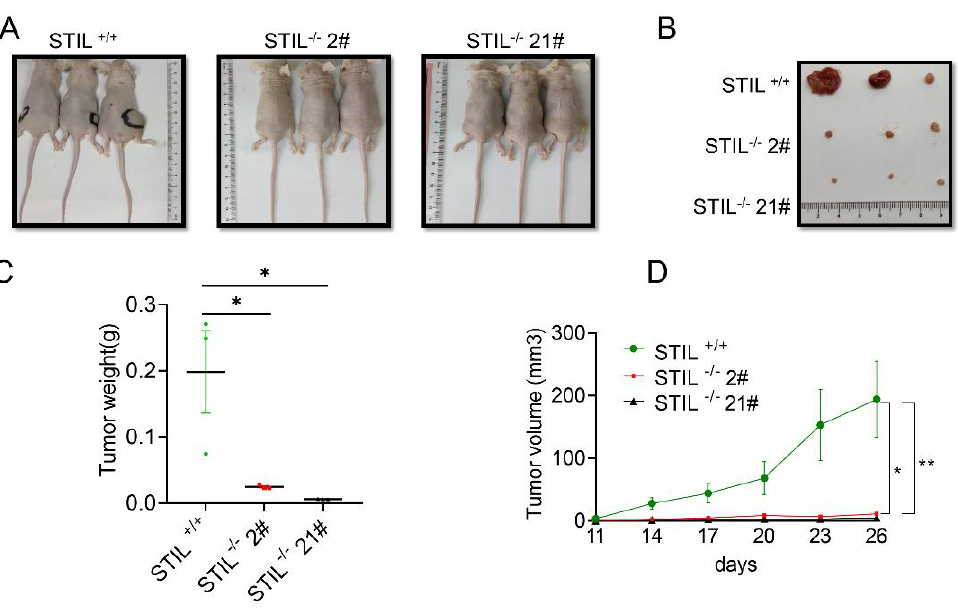
Figure 5. Knockout of STIL played a role in inhibiting tumor growth in vivo. The nude mice were terminated 26 days after cell injection. ( A ) Images of nude mice. ( B ) Images of solid tumors of nude mice. ( C ) Point diagram of the weight of each group of tumors. ( D ) Tumor volume growth curve of nude mice. The nude mice were observed every 3 days after the injection of the cells, and tumor entities were detected from day 11 to day 26 (* p < 0.05 and ** p < 0.01).